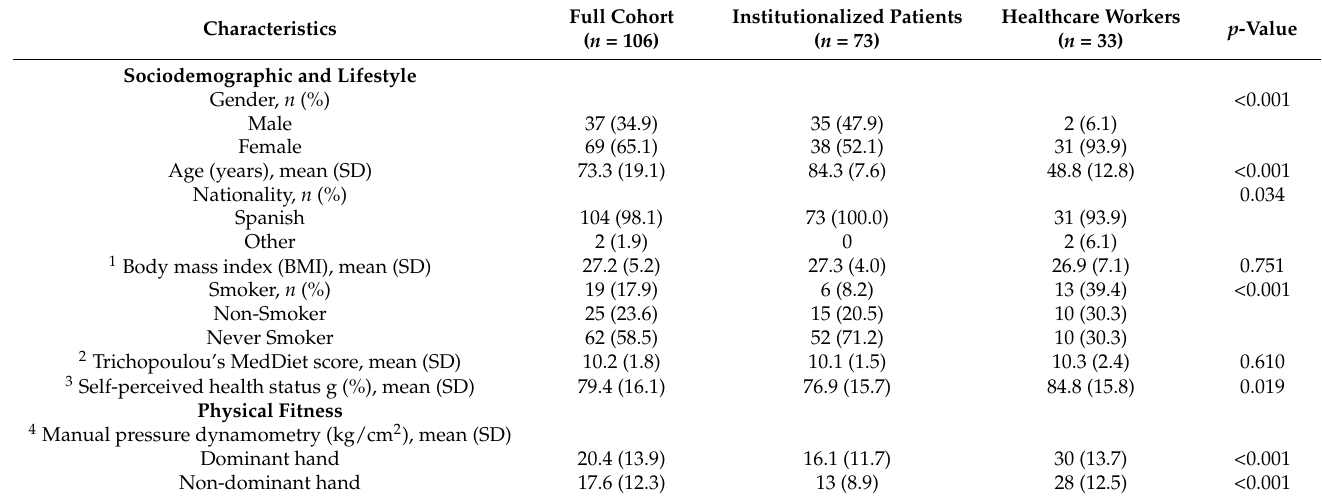
Antibody Levels, Sociodemographic and Lifestyle, Physical Fitness, and Clinical Characteristics-Related with study